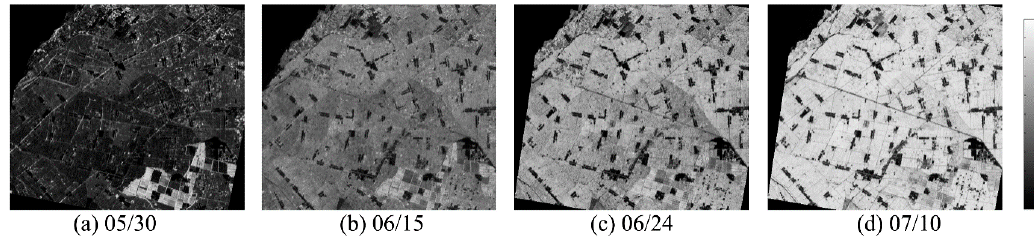
Figure 11. ( a – d ) ASTER FAPAR derived from ASTER NDVI and in-situ FAPAR at four dates.